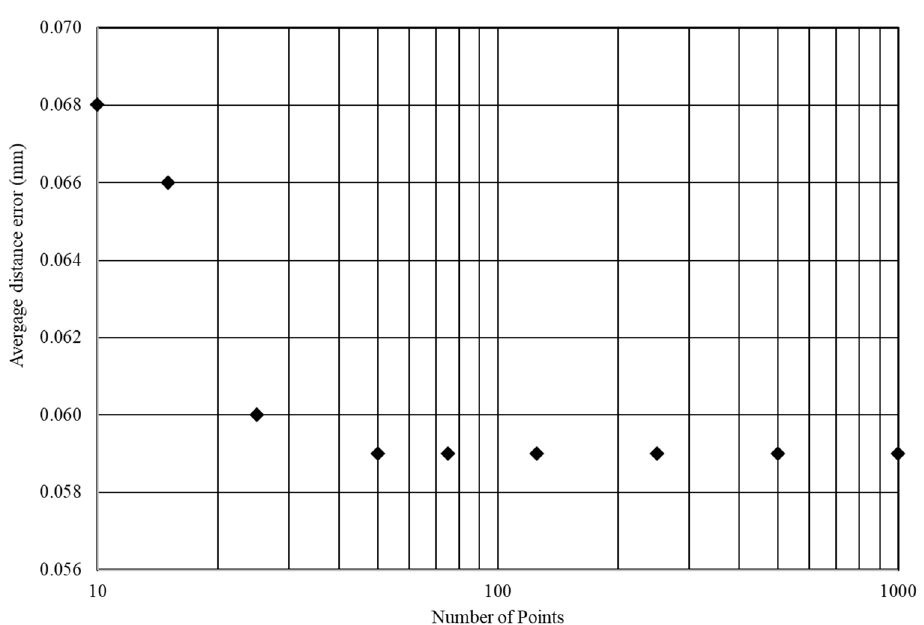
Table 2. Calculations of measured CMM points for one section and deviation to CAD B- Spline shape for vane example.